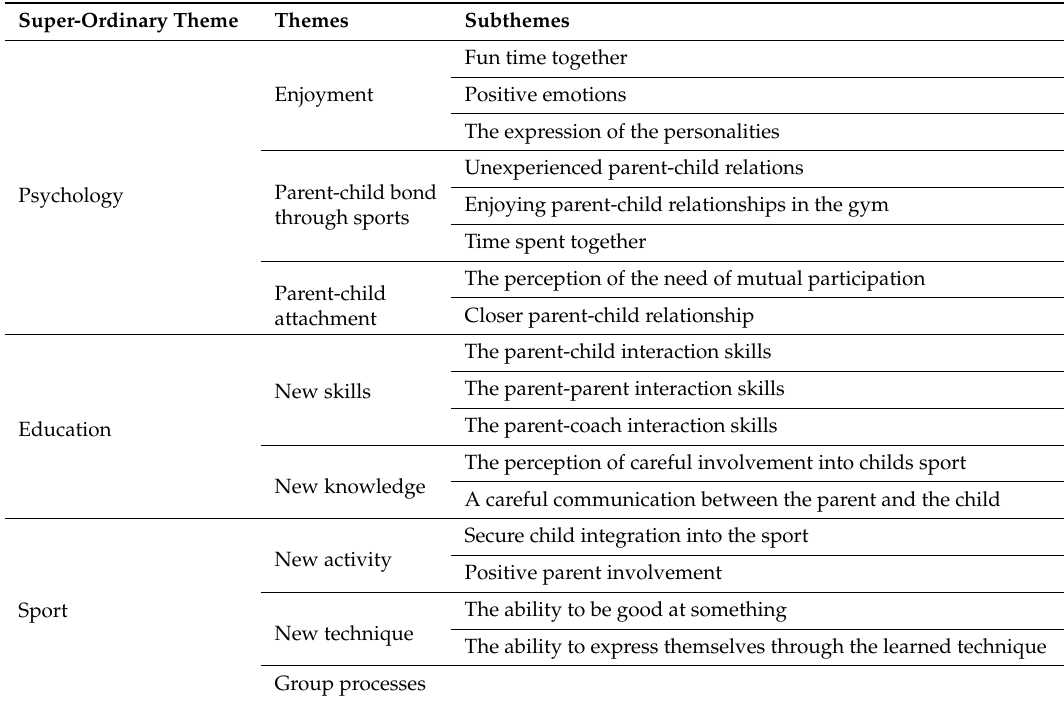
Table 2. During the